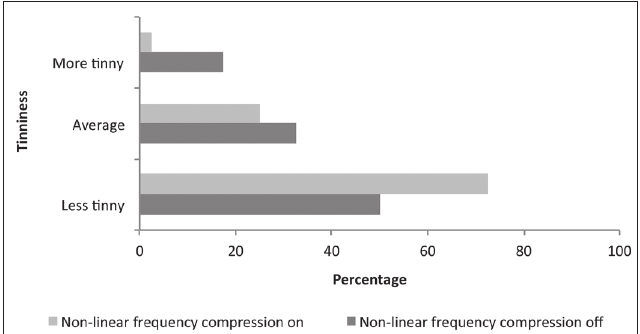
Fig. 7. Participants’ perception of the tinniness of music with NFC off versus NFC on.